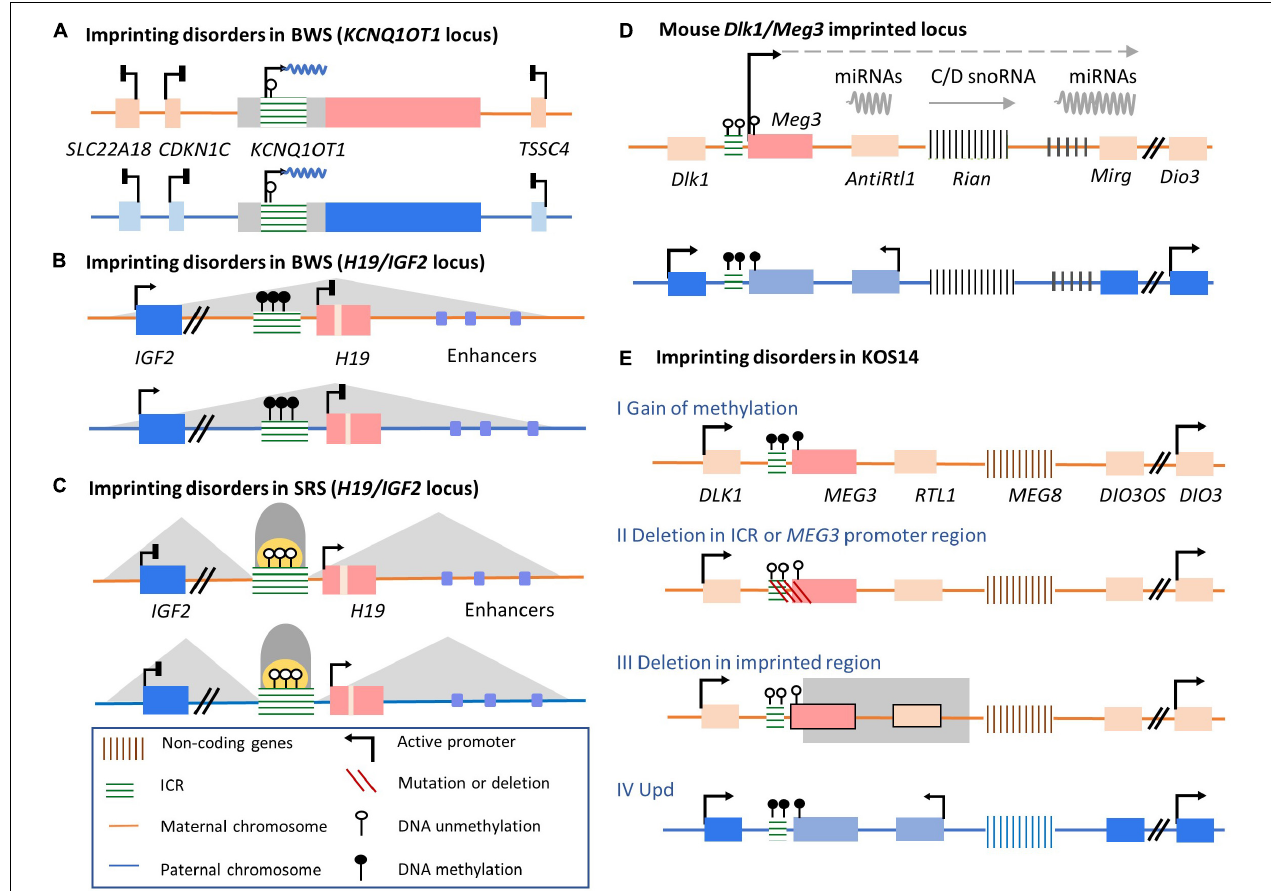
FIGURE 5 | Well-studied imprinting clusters and their conditions in disorder conditions involved in human imprinting disturbance-related diseases. (A, B) BWS and two related imprinted clusters, H19/IGF2 and KCNQ1OT1 . (A) The first situation is the hypomethylation of the maternal allele in Kcnq1ot1 ICR leads to lncRNA KCNQ1OT1 overexpression. The expression of neighboring imprinted genes, such as SLC22A18 , CDKN1C , and TSSC4 , is bi-allelically silenced. (B) The second major imprinting disorder responsible for BWS is hypermethylation of the maternal ICR, resulting in loss of H19 expression and IGF2 overexpression. (C) SRS and alterations in imprinting of H19/IGF2 locus. Hypomethylation of the paternal H19/IGF2 ICR resulting in H19 overexpression and inhibited Igf2 expression. (D) The regulation of mouse Meg3 imprinted cluster. On the paternal allele, the gDMR of Meg3 cluster ICR is methylated, repressing Meg3 lncRNA expression. On the maternal allele, lncRNAs are transcribed from the promoter within the unmethylated ICR. (E) Four cases of MEG3- related imprinting disorders in KOS14 patients are shown. Line I, epimutations in normally activated maternal ICR of MEG3 cluster result in loss of lncRNA transcription, releasing normally silenced adjacent imprinted genes; Line II: maternal deletion in ICR of MEG3 regions; Line III: maternal deletion in the MEG3 gene body; Line IV: both alleles are inherited by silenced paternal